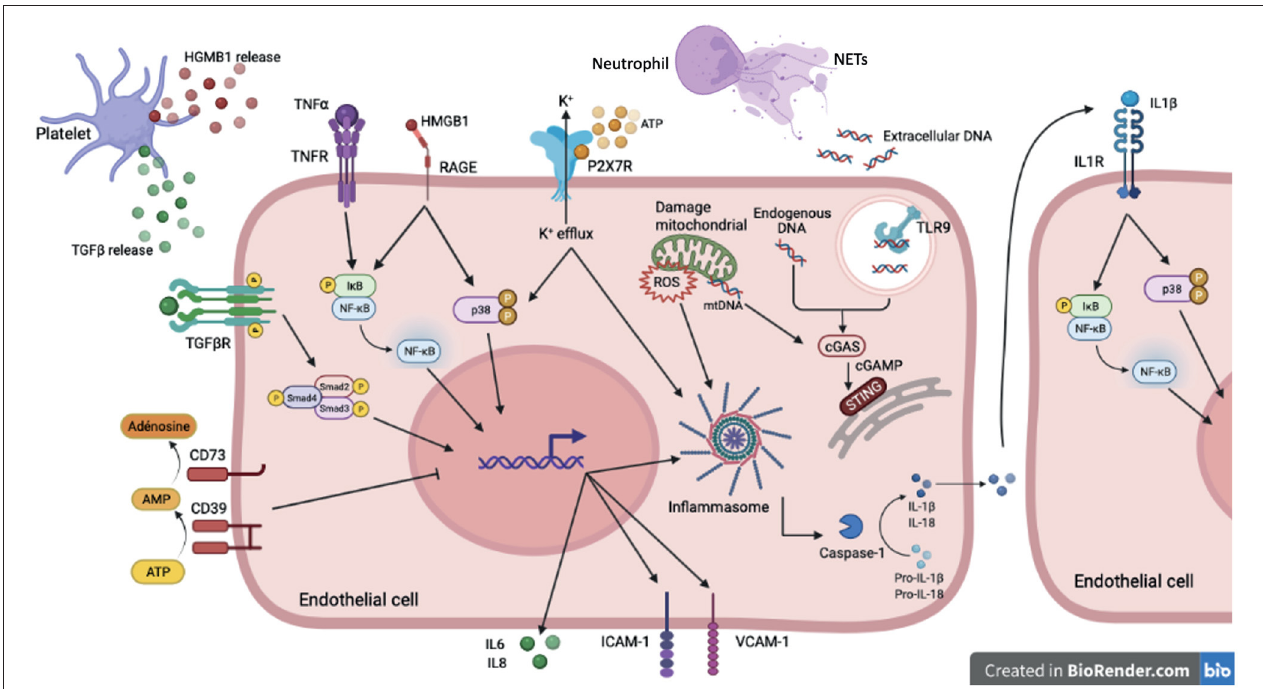
FIGURE 2 | DAMP sensing by endothelial cells and signaling pathways induced downstream PRRs in sterile inflammation. In sterile inflammation, damage-associated molecular patterns (DAMPs) can activate pattern recognition receptors (PRRs). These extra- or intracellular DAMPs are recognized by many cell types including endothelial cells. Among PPRs, some are membrane receptor such as TLRs, cytokines receptors, purinergic receptor and some are intracellular receptor including cytoplasmic NLRP3 or reticuloplasmic STING. Cytokines (TGF β , TNF α , IL-1 β ) activate via their receptors (TGF β R, TNF α R, IL1 β R) many signaling pathways such as NF κ B, p38 MAPK and SMAD. These pathways promote pro-inflammatory gene activation including IL-6 and IL-8 but also ICAM-1 and VCAM-1 involved in recruitment and adhesion of immune cells on the endothelium. The high-mobility group box 1 protein (HMGB1) mediates its pro-inflammatory effects through binding to RAGE and activation of MAP kinases and NF κ B pathways. The assembly of the NLRP3 inflammasome, which allows the cleavage of the cytokines IL-1 β and IL-18 into their active form, is activated by several stimuli. Binding of extracellular ATP to P2X7R results in Ca 2 + influx and K + efflux. K + efflux can induce NLRP3 inflammasome activation. To counteract pro-inflammatory effects of ATP, the ecto-nucleotidase CD39/CD73 hydrolyzes ATP to adenosine thus preventing its binding to P2XR7. The reactive oxygen species (ROS) production by the mitochondria also contribute to NLRP3 inflammasome assembly. Extracellular DNA derived from cell damage can be recognized by TLR9. Intracellular and mitochondrial DNA activate cGAS signaling in the cytoplasm. Activation of cGAS induces the production of cyclic second messenger GMP—AMP (cGAMP), which binds and activates STING at the endoplasmic reticulum.